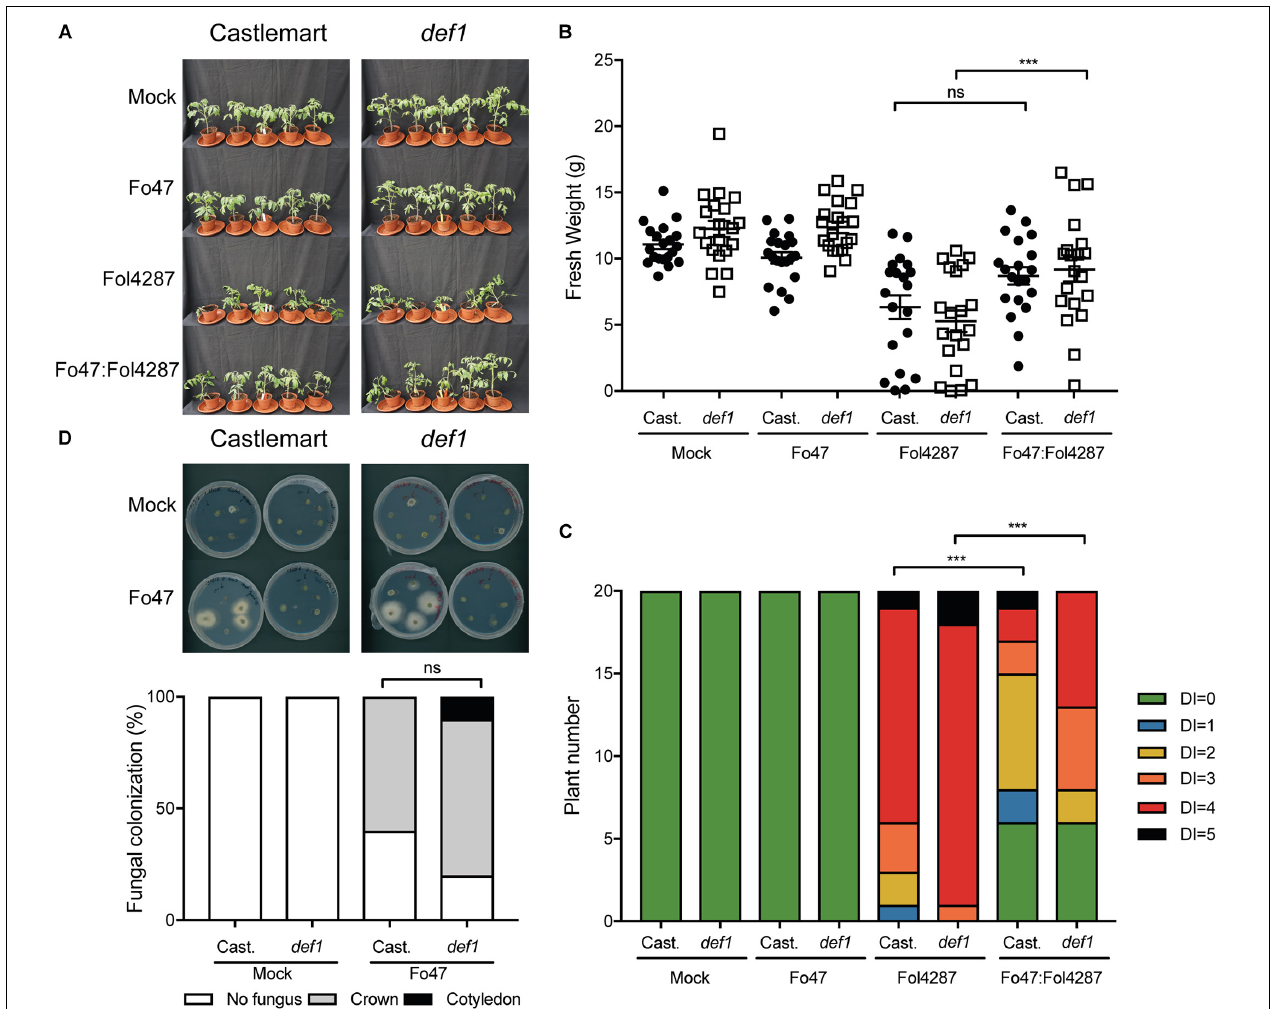
FIGURE 3 | Impaired jasmonic acid biosynthesis does not affect EMR triggered by Fo47. (A) Ten days old tomato seedlings (Castlemart) and def1 plants impaired in JA production were inoculated with water (mock), Fo47, Fol4287 or co-inoculated with Fo47 and Fol4287. Disease development was assessed by measuring fresh weight (B) and disease index (C) 3 weeks after inoculation. Raw data was analyzed by a non-parametric Mann–Whitney U -test ( ns P > 0.05, ∗∗∗ P < 0.001). The bioassay was performed three times with similar results [where the number of plants (n) was n = 10 for the first repetition and n = 20 for the second and third repetition]. (D) Representative stem pieces taken from crown (left) and cotyledon (right) level of five individual plants incubated for 4 days on PDA plates. Percentage of Fo47 colonization on mock-inoculated plants ( n = 10) and Fo47 treated plants ( n = 20). The experiment was performed twice with similar results. Raw data was analyzed by a non-parametric Mann–Whitney U -test ( ∗∗∗ P <